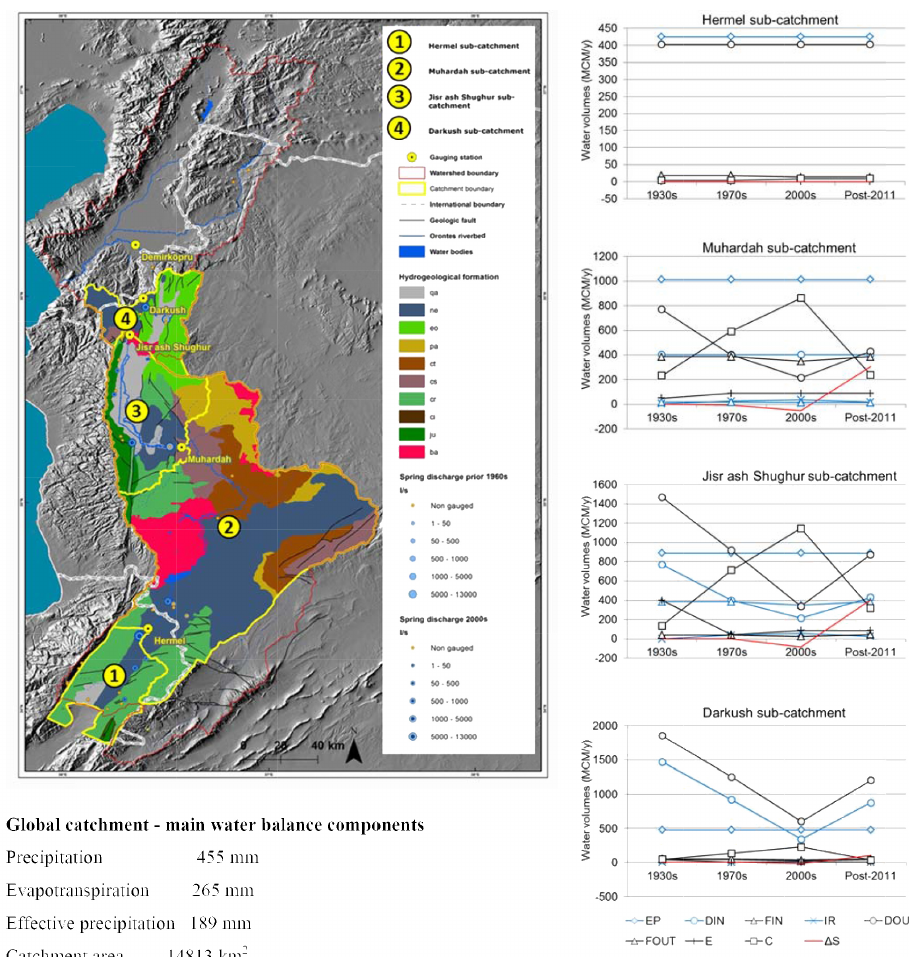
Figure 3. Historical water balance in the Lebanese and Syrian parts of the Orontes River basin. EP: Effective precipitation; DIN: River discharge (inflow); FIN: Ground water or surface water inflow; DOUT: River discharge (outflow); FOUT: Ground water or surface water outflow; E : Water surface evaporation; C : Anthropic evapotranspiration; (cid:49)S change in groundwater